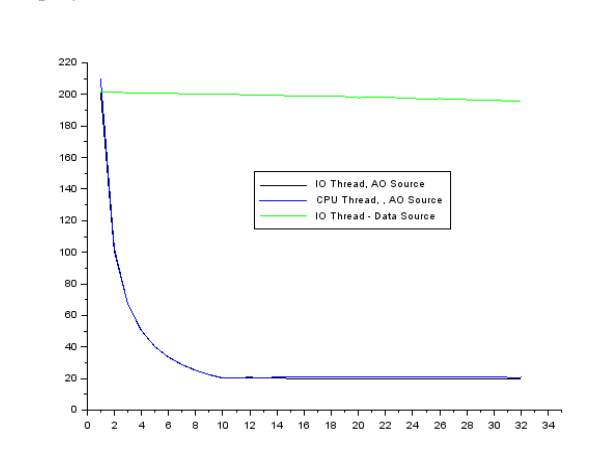
Figure 9. Illustration of the Scalability with Number of